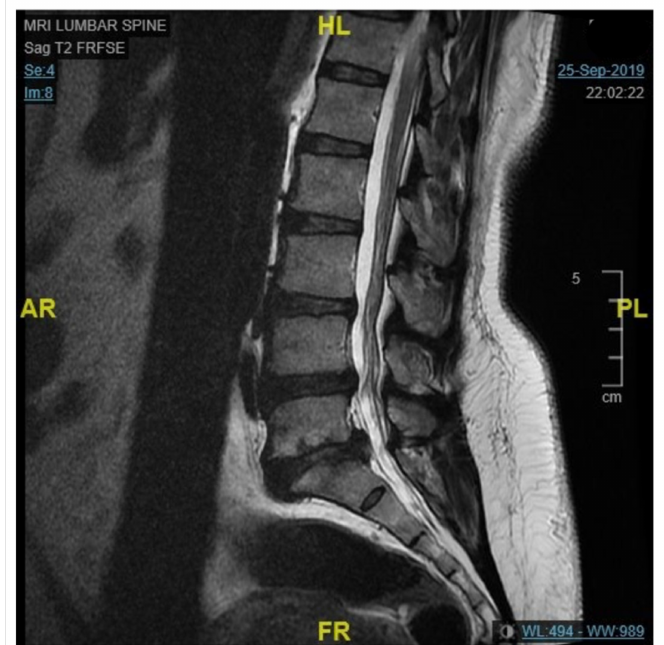
Figure 1. Original design of the MRI lumbar spine image.